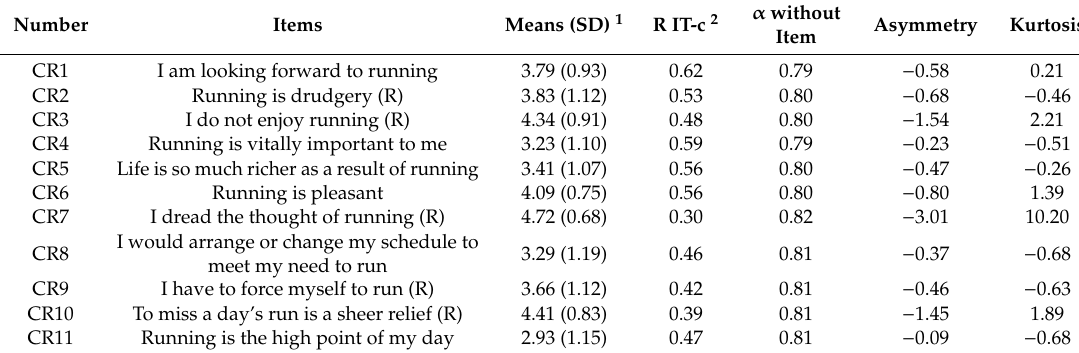
Table 2. Mean, standard deviation, corrected item–total correlation, alpha if the item is removed, asymmetry, and kurtosis values of the indicators of the running-commitment scale.